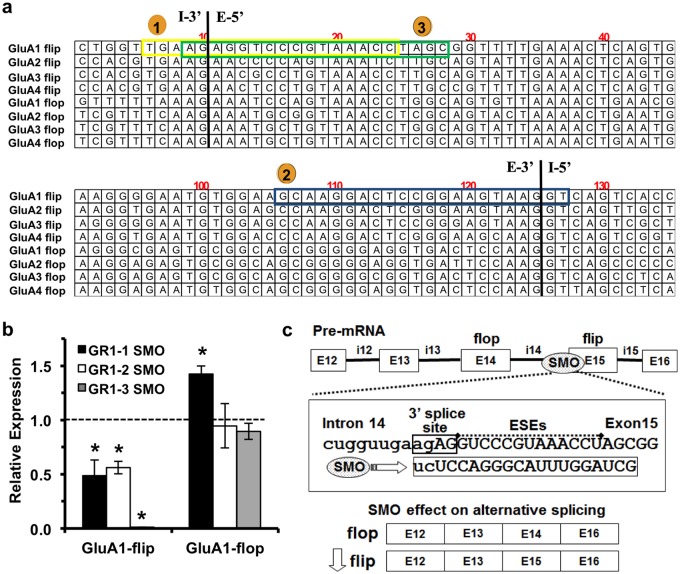
Development of GR1 SMO.(a) Target binding location of top three SMO tested for splicing activity against GluA1 flip isoforms; 1. GR1-1 (yellow), 2. GR1-2 (blue), and 3. GR1-3 (green). (1) GR1-1 SMO was targeted to the 3’ splice site. (2) GR1-2 SMO was targeted to the 5’ splice site. Finally, (3) GR1-3 SMO was optimized from the GluR1-1 SMO at the 3’ splice site. Initial in vivo testing was performed in neonatal mice. Mice were injected with SMO (2 μg/ventricle) at postnatal (P) days P1, P3, and P5, tissues harvested at P6, and mRNA expression normalized to saline-injected mice (dotted line). (b) Testing of GluA1-flip targeting SMOs in P6 mice (n = 3–5). While all 3 candidate SMOs displayed some on-target splice modulation, only GR1-3 showed a nearly complete knockdown of GluA1-flip with no significant effect on GluA1-flop. Thus, GR1-3 was chosen as the therapeutic SMO to proceed forward in our studies, designated as GR1. (p < 0.05) (c) Schematic showing the mechanism of action of GR1 on GluA1 pre-mRNA splicing. The flip and flop exons are tandem 115 nucleotide exons which are spliced from GluA pre-mRNA in a mutually exclusive pattern. Through Watson-Crick base pairing, GR1 binds to the complementary site at the 3’ splice site of the GluA1-flip exon, sterically inhibiting the spliceosome from recognizing the intron/exon boundary and predicted exonic splice enhancer (ESE) motifs, causing exclusion of the GluA1-flip exon.